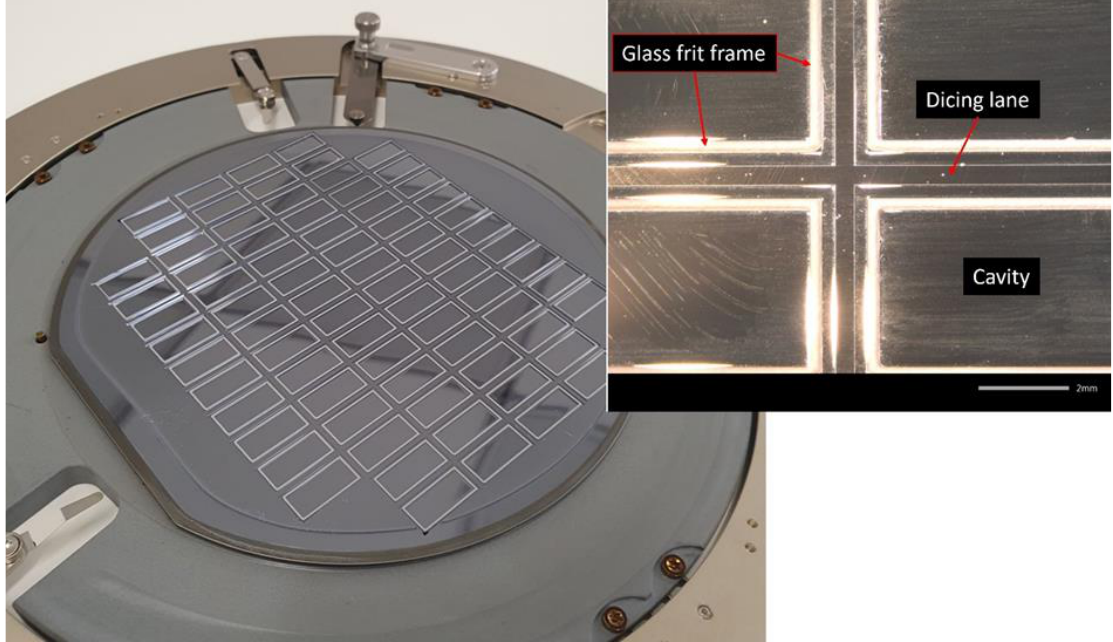
Figure 8. A demonstration of the 6 ″ silicon cap wafer with the jetted glass frit paste at different magnifications.